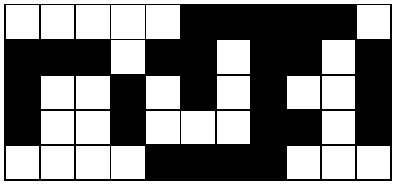
Figure 6. Another example